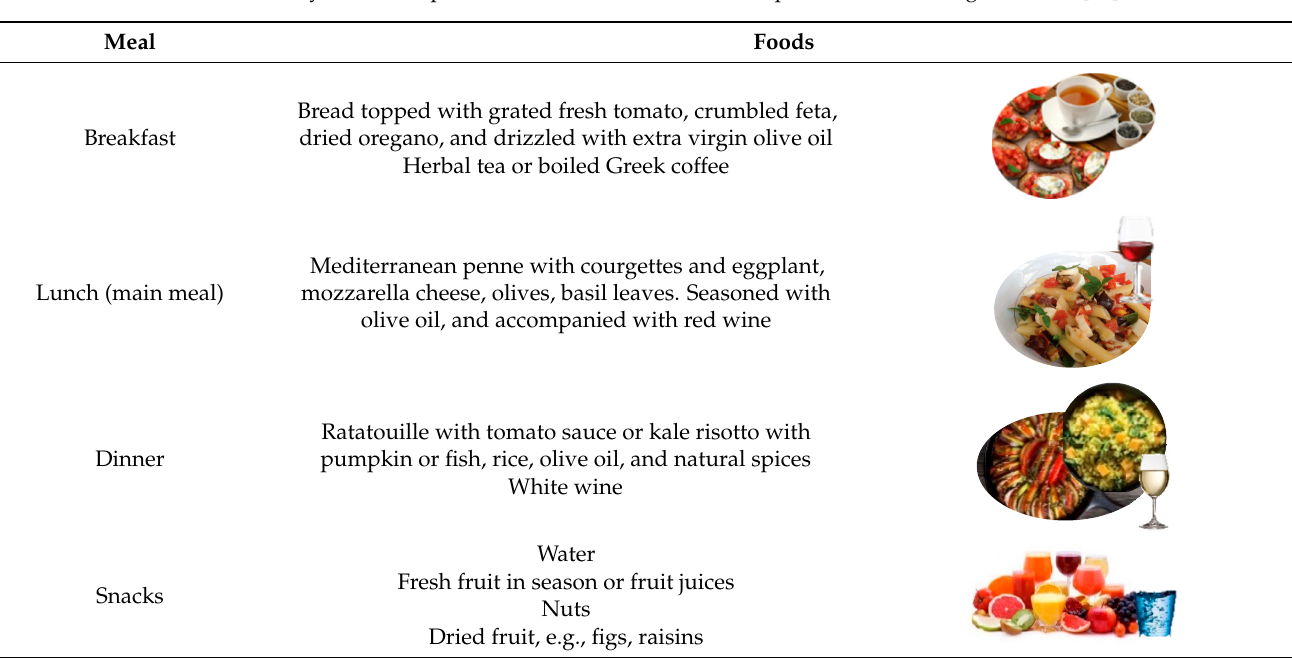
Table 4. Total phenol content and total phenol antioxidant index (PAOXI) of fruits. Adapted from [53,55]. Fruit